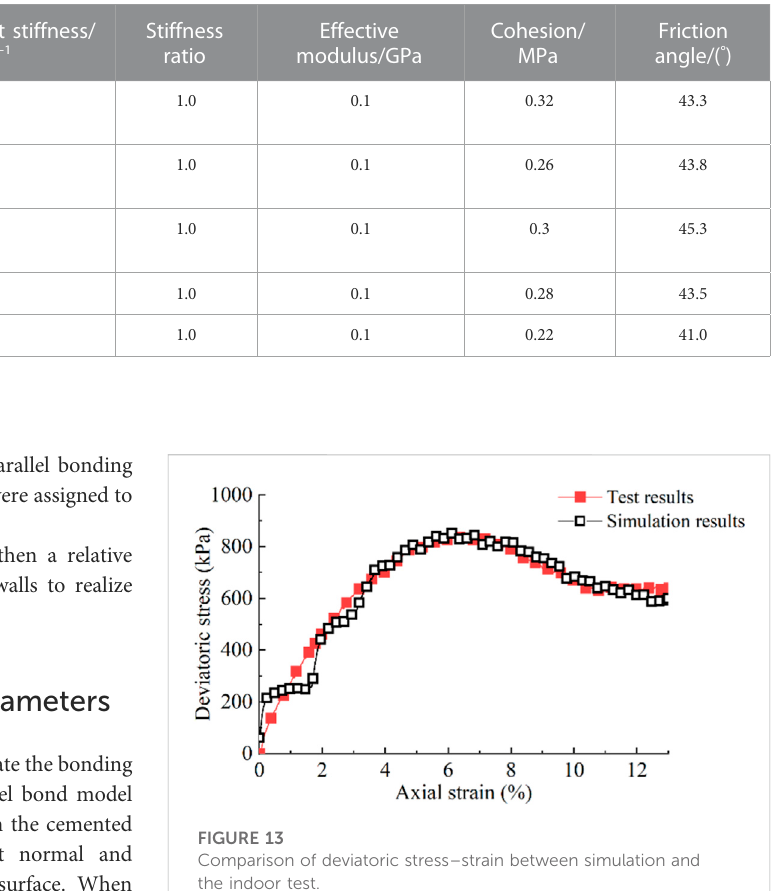
TABLE 3 Mesoscopic parameters of a numerical sample.